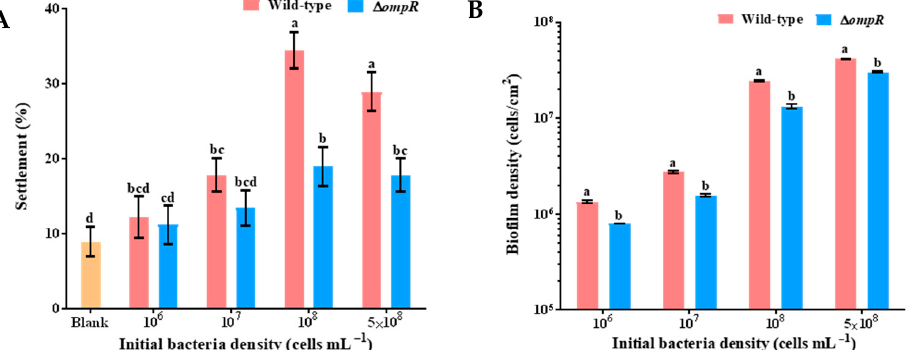
Figure 4. The effect of wild-type biofilms and ∆ ompR biofilms on mussel settlement and the biofilm density with different initial bacterial densities. ( A ) Inducing activities of biofilms formed by tested strains on mussel settlement; and ( B ) biofilm density on glass slips with different initial bacterial densities of tested strains. Different letters indicate significant differences ( p < 0.05).